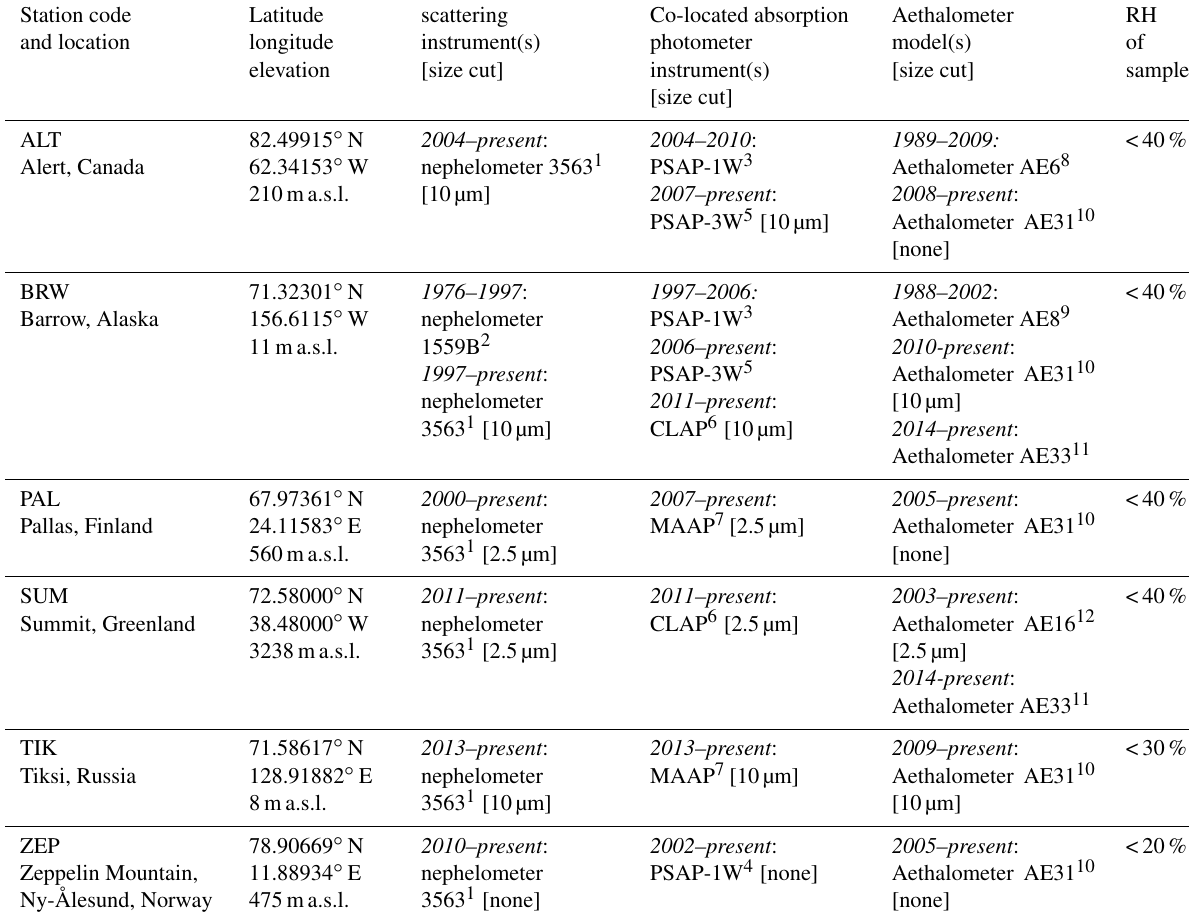
Table 1. Monitoring station names, locations, scattering and absorption instruments, size cuts, and humidity of samples. Bolded instruments indicate those from which data are used in this